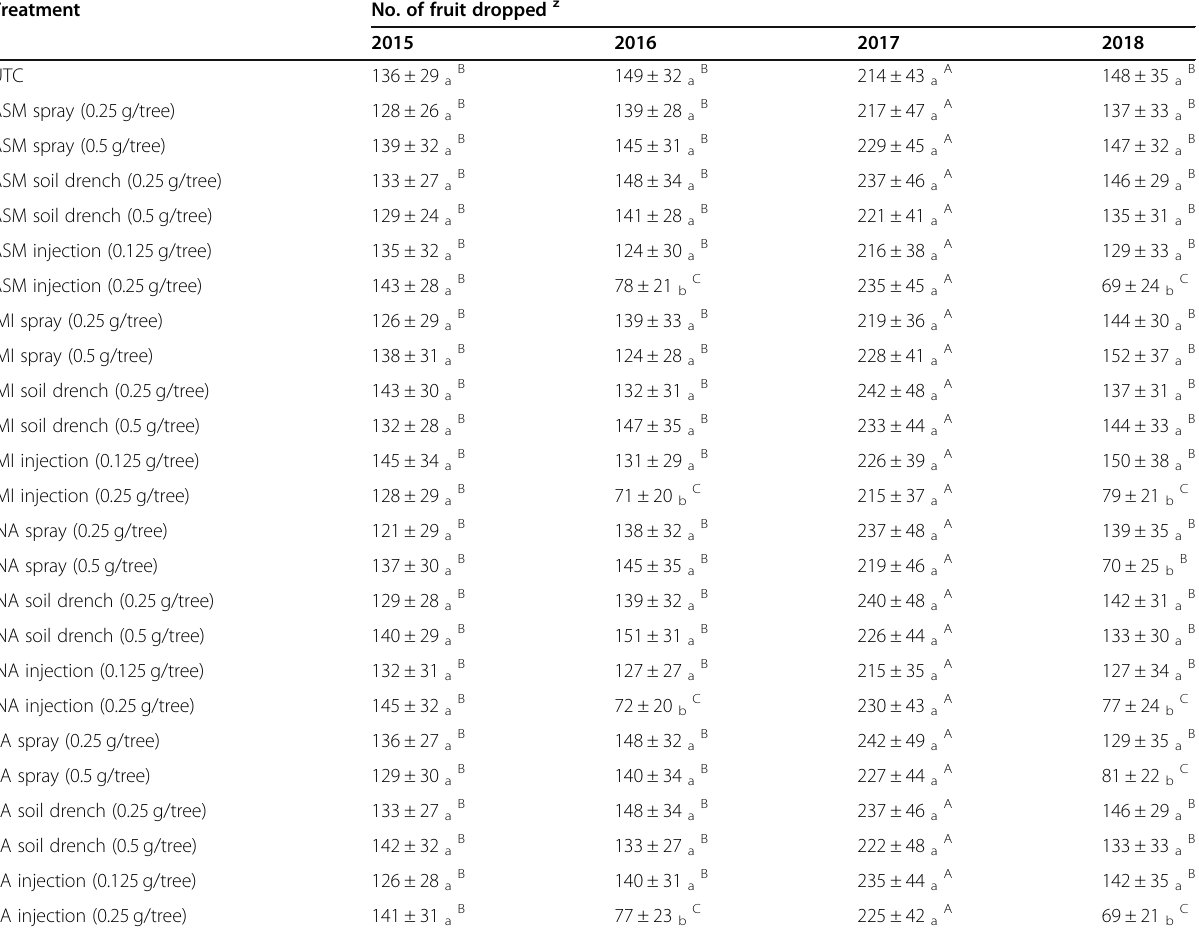
Table 3 Pre-harvest fruit drop of Hamlin sweet orange trees treated with various SAR inducers in a three-year field trial (2015 – 2018) Treatment No. of fruit dropped